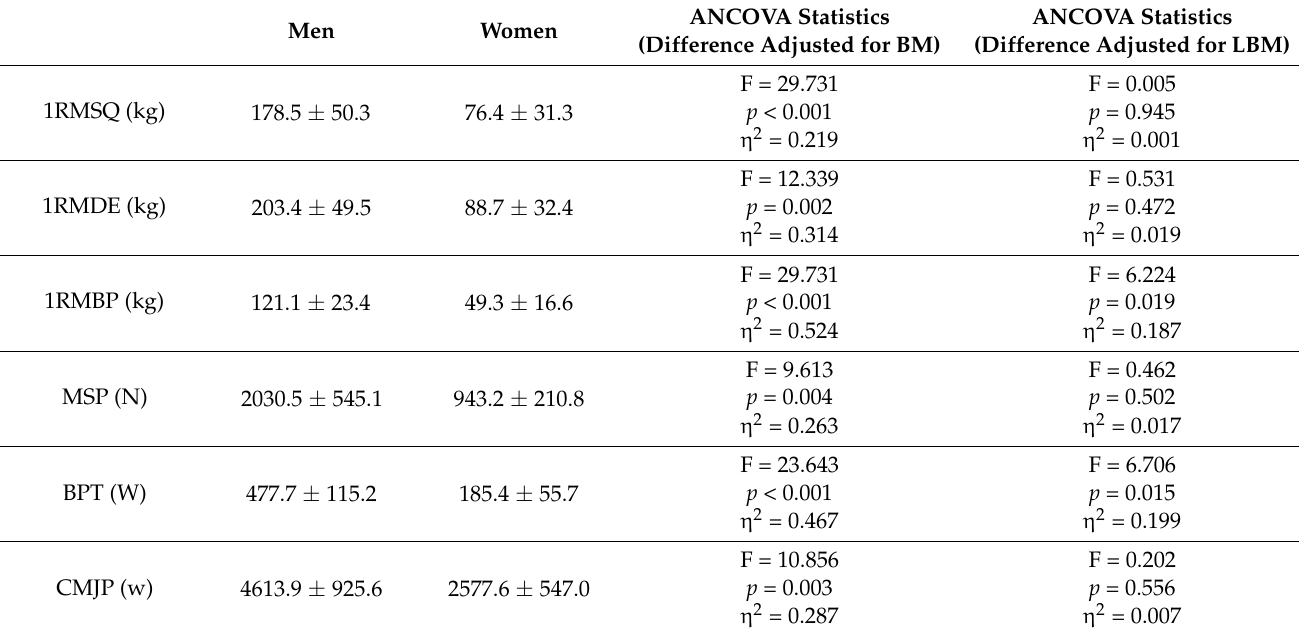
Table 2. Mean ± SD values for maximal strength and power in men and women. SQ = squat; DE = deadlift; BP = bench press; MSP = mid-shin pull; BPT = bench press throw; CMJP = countermovement jump power. F = ANCOVA F η 2 = partial eta squared. ANCOVA = analysis of covariance. ANCOVA Statistics ANCOVA Statistics Men Women (Difference Adjusted for BM) (Difference Adjusted for LBM) F = 29.731 F = 1RMSQ (kg) 178.5 ± 50.3 76.4 ± 31.3